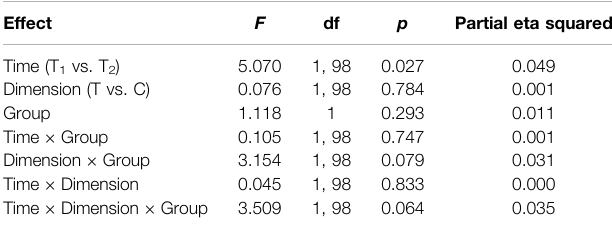
TABLE 5 | Predicting explicit